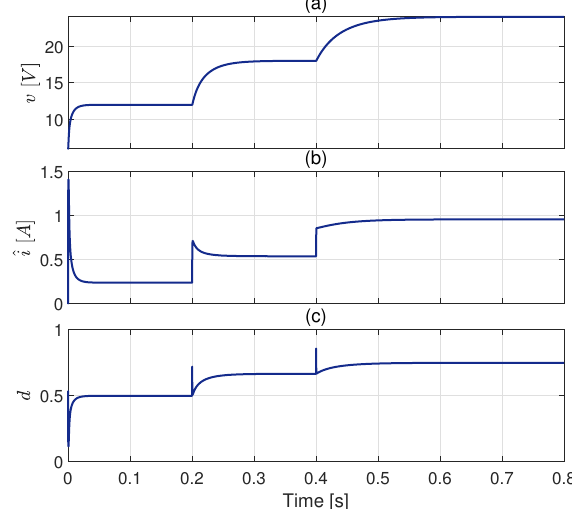
Figure 5. Response curves of boost converter under the proposed sensorless controller with differ- ent references. ( a ) Output voltage v , ( b ) estimated current ˆ i , ( c ) duty ratio d